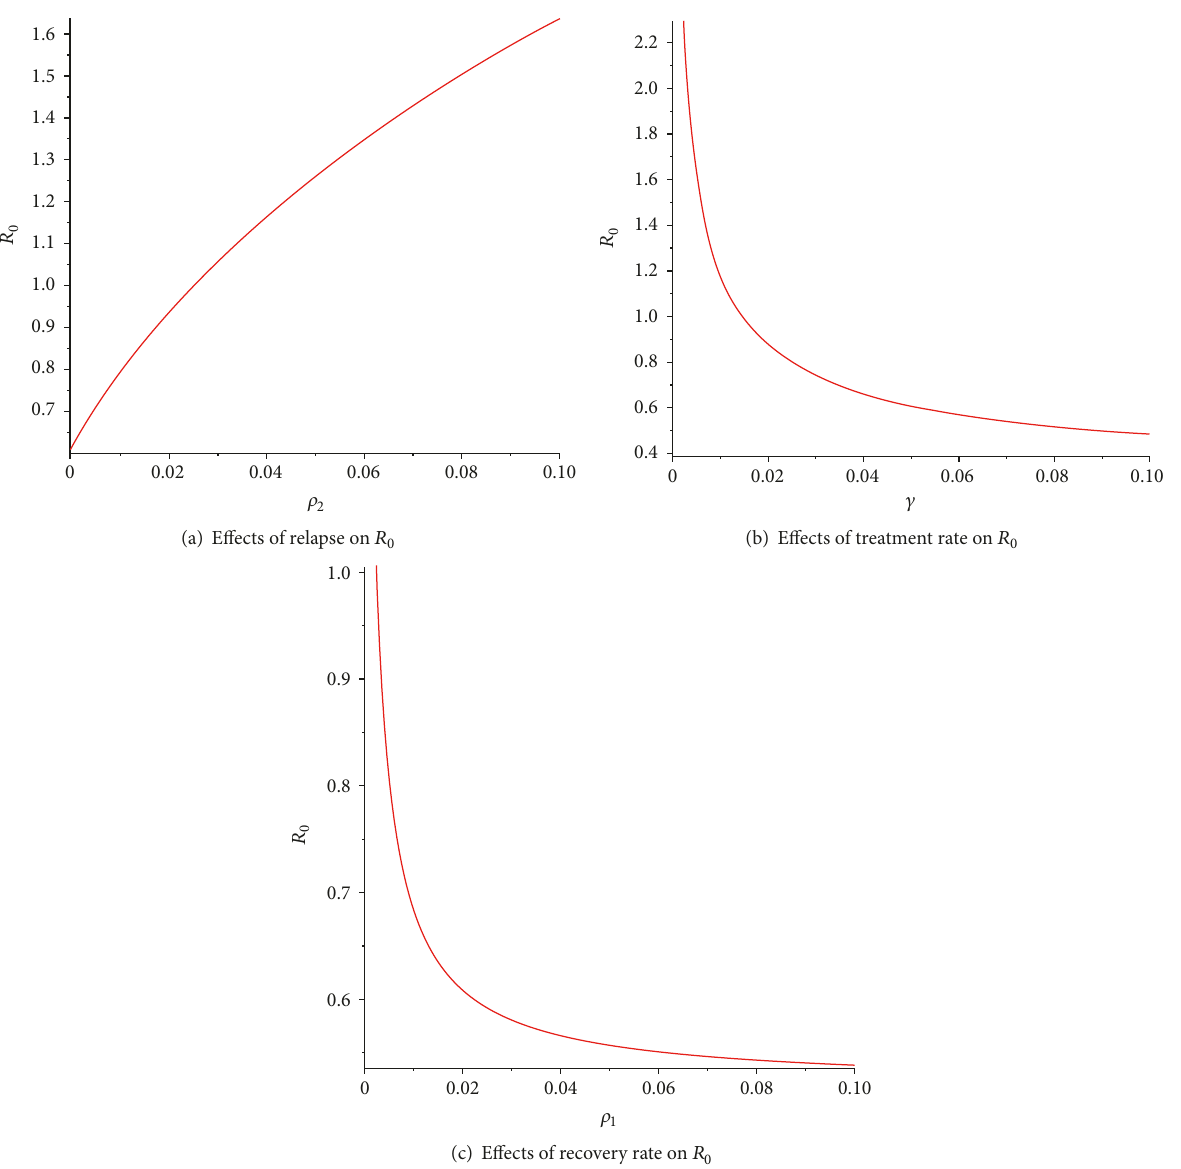
Figure 4: Effects of relapse and recovery rate on 𝑅 0